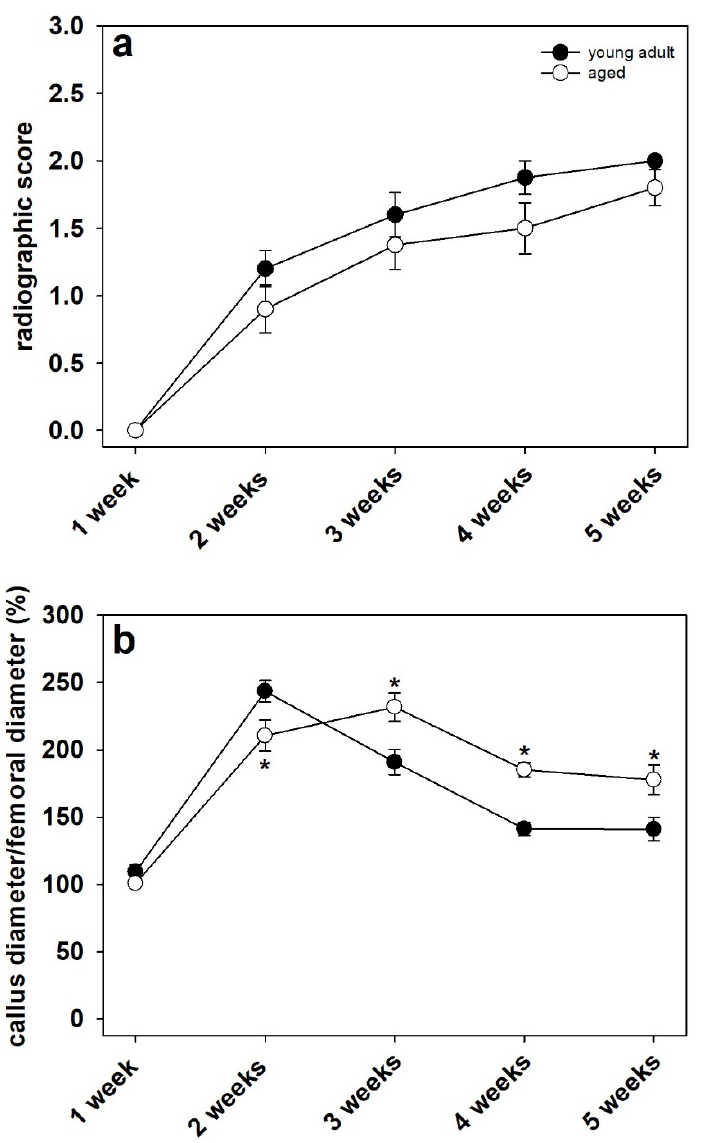
Figure 3. ( a ) Analysis of the radiographic score at 1, 2, 3, 4 and 5 weeks after fracture in young adult (black circles, n = 10) and aged (white circles, n = 10) CD-1 mice (Mann–Whitney U test used at 1, 2, 3, 4 and 5 weeks). ( b ) Analysis of the callus diameter/femoral diameter (%) at 1, 2, 3, 4 and 5 weeks after fracture in young adult (black circles, n = 10) and aged (white circles, n = 10) CD-1 mice (Mann–Whitney U test used at 1 week, Student’s t -test used at 2, 3, 4 and 5 weeks). Means ± SEM; * p < 0.05 vs. young adult.